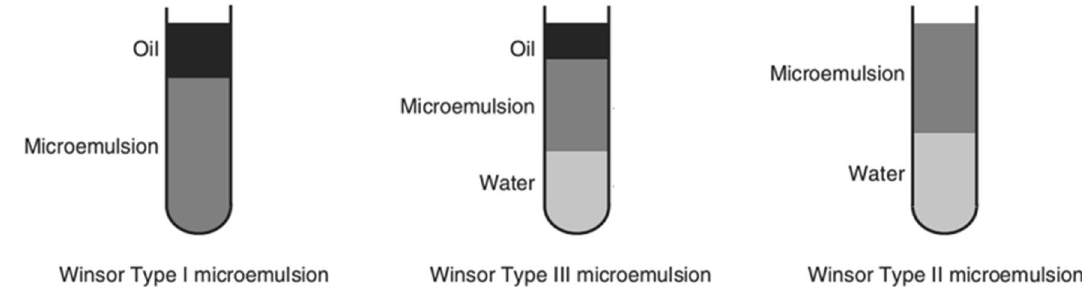
Fig. 6 Three types of microemulsions adapted from James Sheng